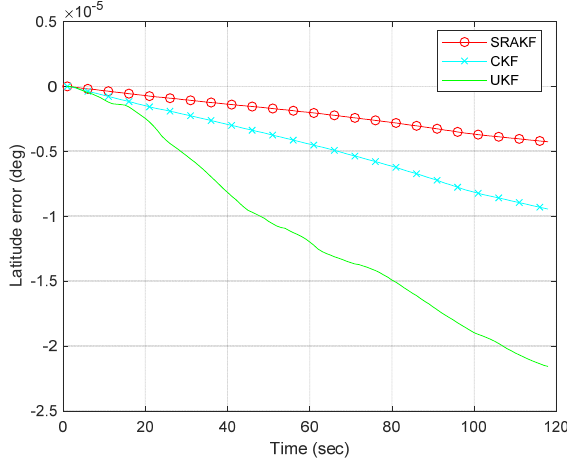
Figure 13. Latitude errors for the underwater lake trial.